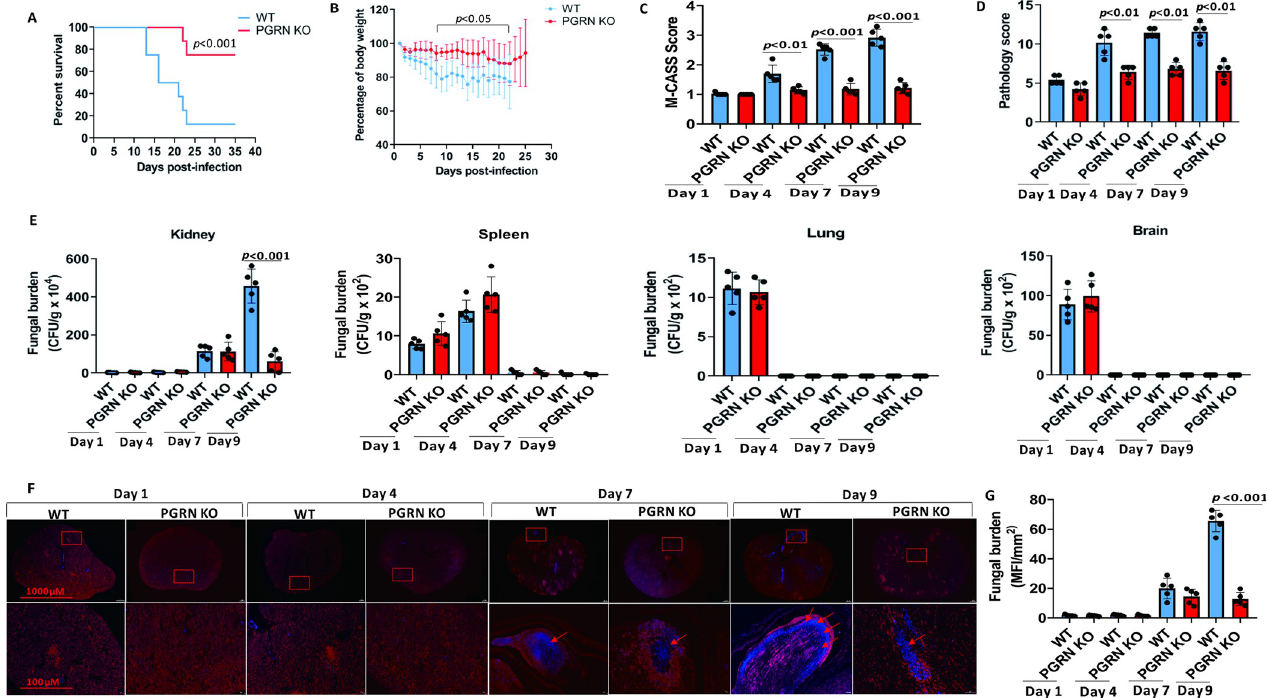
Fig 2. PGRN deletion decreased the susceptibility to invasive C . albicans infection in mice. (A) PGRN knockout (KO, n = 20) and wild type (WT, n = 20) mice were infected intravenously with 4 × 10 5 colony forming units (CFU) of C . albicans . Survival was monitored over indicated time periods. (B) Weight changes of mice after intravenous infection with 4 × 10 5 CFU of C . albicans in WT (n = 10) and PGRN KO (n = 10) mice. (C) Mouse Clinical Assessment Score for Sepsis (M-CASS) scores of WT (n = 5) and PGRN KO (n = 5) mice after intravenous infection with 4 × 10 5 CFU of C . albicans . (D) Pathology scores in the kidneys after intravenous infection with 4 × 10 5 CFU of C . albicans in WT (n = 5) and PGRN KO (n = 5) mice. (E) Fungal titers in the tissues, including kidneys, spleens, lungs and brains, were determined at the indicated times after intravenous infection with 4 × 10 5 CFU of C . albicans in WT (n = 5) and PGRN KO (n = 5) mice. (F) Representative Calcofluro White (CW) staining of kidney sections from WT (n = 5) and PGRN KO (n = 5) mice after invasive C . albicans infection. Red arrows indicated hyphae of blue staining. Bottom panels are high magnification. Scale bars are 100 μ M. (G) Fungal load score by analysis of CW- stained kidney sections at the indicated times after invasive C . albican s infection in WT (n = 5) and PGRN KO (n = 5) mice. MFI = mean fluorescence intensity. All data were pooled from three independent experiments. Log-rank test was used to analyze the difference between survival curves. The Mann–Whitney U test was used to analyze the difference of other parameters between WT and PGRN KO mice at the same time point after C . albicans infection, and p values were shown when compared between groups denoted by horizontal lines.